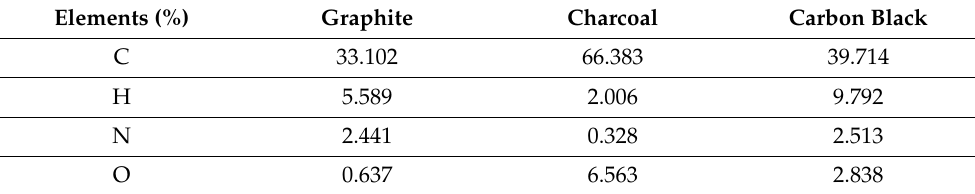
Table 4. Elemental constituents (percent) of reducing agents from CHNSO